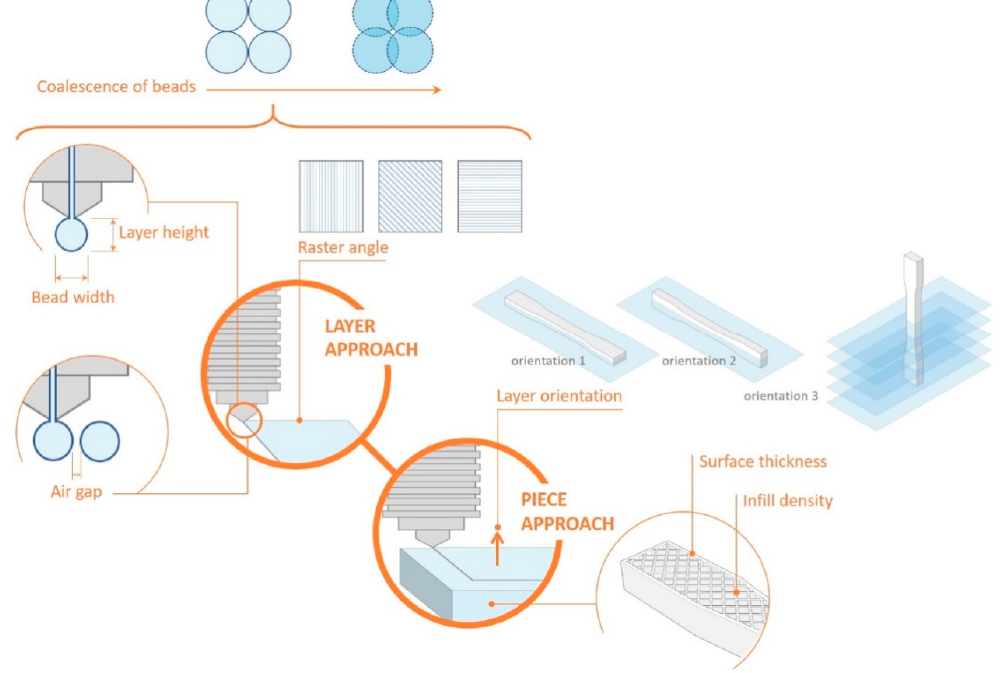
Figure 4. The geometrical parameters with a direct influence on the mechanical properties of pieces manufactured using FDM.